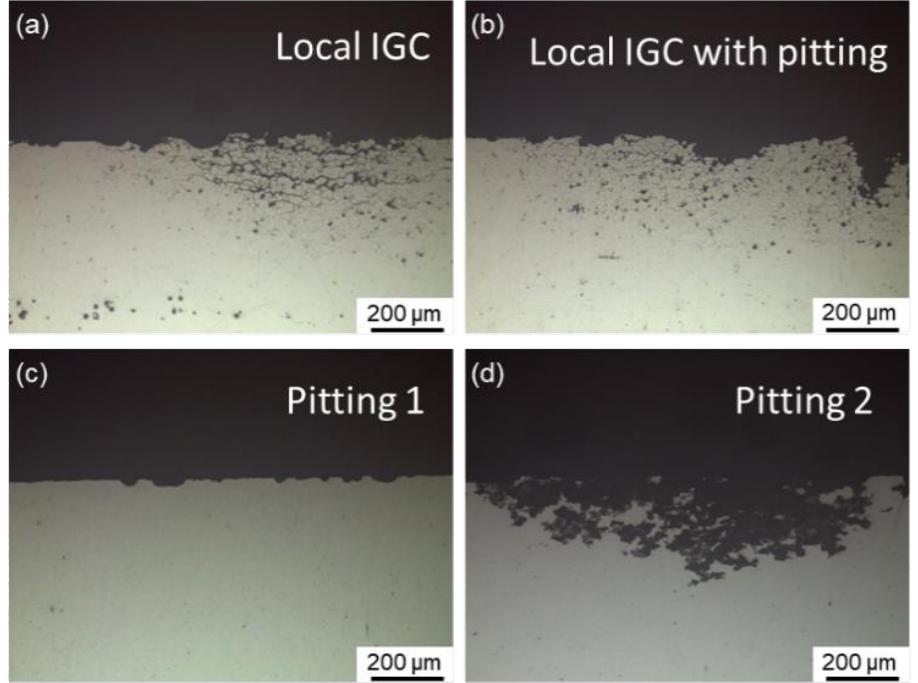
Figure 4. Representative cross-sectional corrosion morphologies of Al–Cu–Li alloys with different Mg content immersed for 6 h in 1 M NaCl + 0.1 M H 2 O 2 solution, representing: ( a ) local IGC (1.1Mg alloy aged for 0.5 h) and ( b ) local IGC (1.1Mg alloy aged for 1 h) with pitting, ( c ) pitting 1 (Mg-free alloy aged for 97 h) and ( d ) pitting 2 (0.7Mg alloy aged for 50 h). Table 3. Corrosion mode, maximum and average depth of investigated alloys aged for different